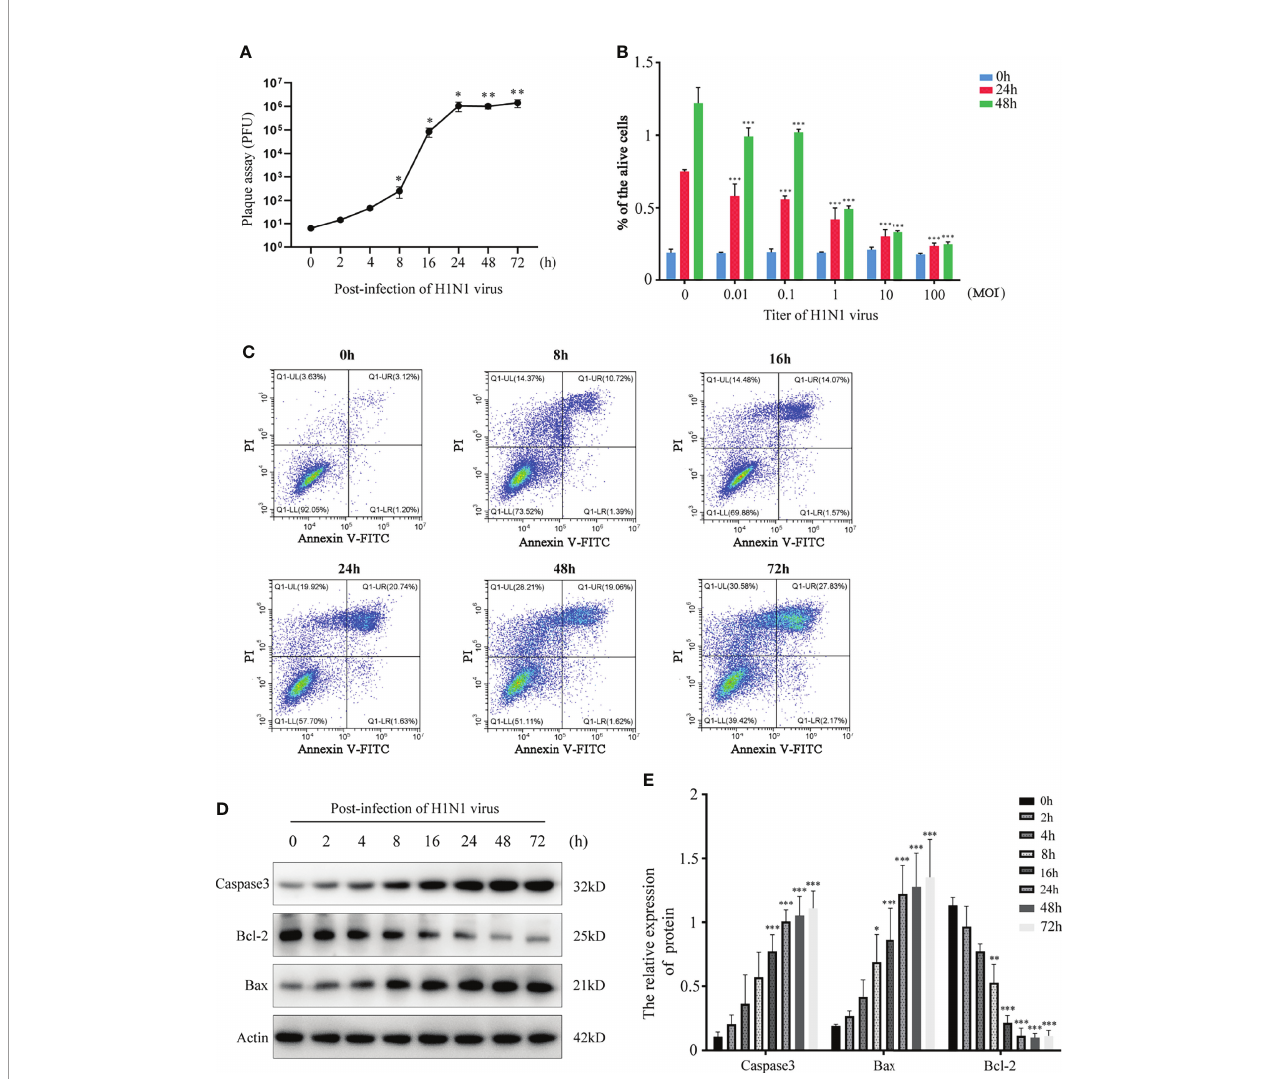
FIGURE 1 | H1N1 in fl uenza virus affects the activity of hNEPCs and promotes apoptosis. (A) Viral plaque formation was used to detect the ampli fi cation of progeny viruses of H1N1 virus in hNEPCs. (B) After 24h and 48h infection with different titers of H1N1 virus, the cell viability was detected by MTT. (C) Flow cytometry was used to detect the changes of apoptosis levels after cells were infected with 0.1MOI titer virus for 0-72 hours. (D) Detection of apoptosis-related protein expression levels after cells were infected with 0.1MOI titer virus for 0-72 hours.Virus stimulation was increased at different time points, cells were collected at the same time point, and the 0-hour group was the control group. (E) The bar graphs show quanti fi cation of the apoptosis-related protein expression levels, with each value represents the mean ± SD of three independent experiments. Statistical signi fi cance is shown using the Student ’ s t test analysis, *P < 0.05; **P < 0.01; ***P <